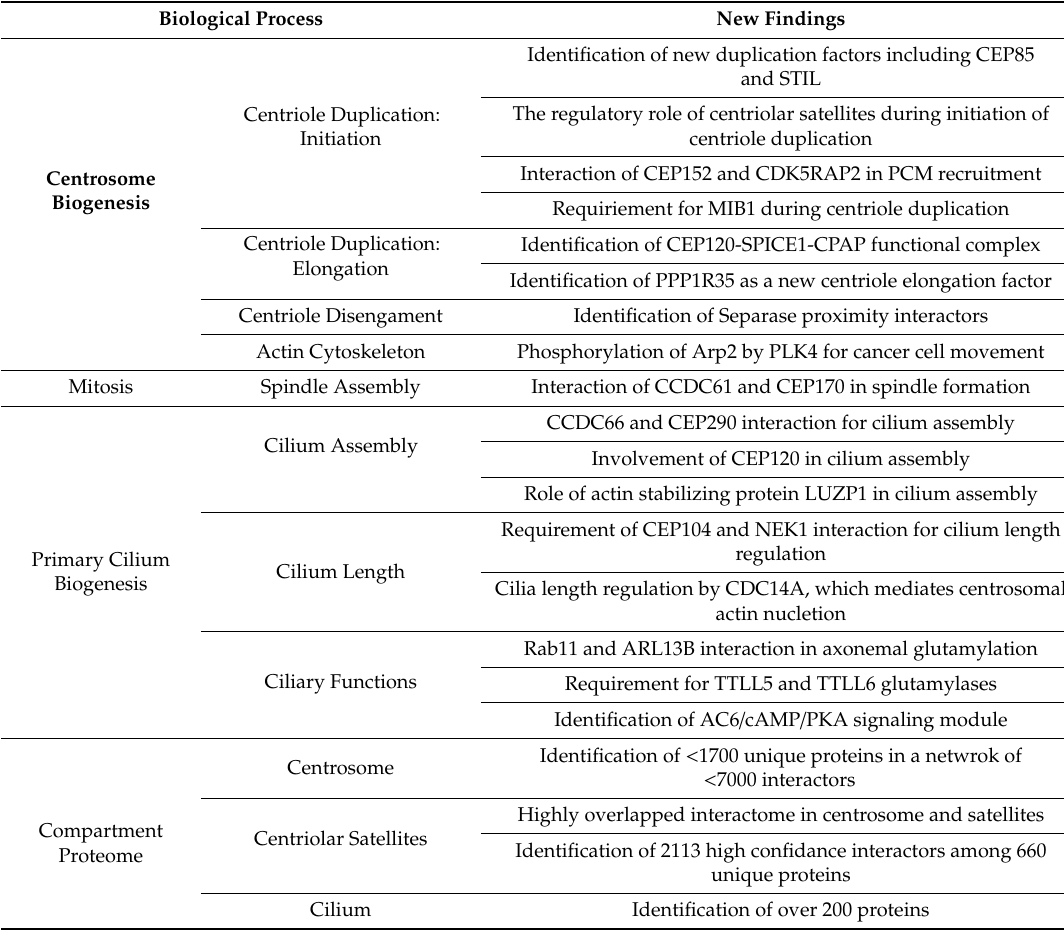
Table 3. Biological insight gained from the application of proximity-based labeling approaches to the centrosome / cilium complex. Major findings were categorized in the context of centrosome biogenesis, mitosis, primary cilium biogenesis and compartment